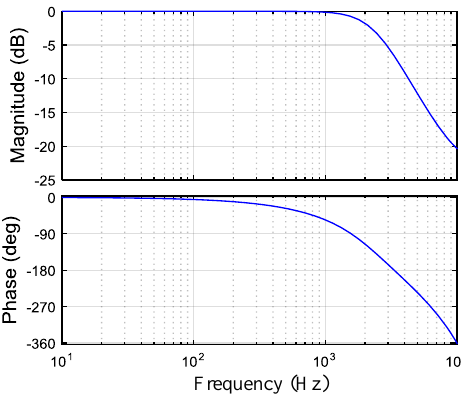
Figure 10. Bode diagrams of current closed-loop transfer function when τ = 3 T s.